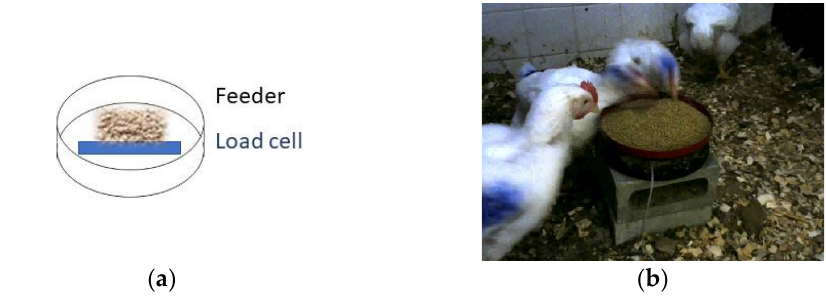
Figure 1. Schematic view of the sensor ( a ) and a photograph of the broilers pecking the feed ( b